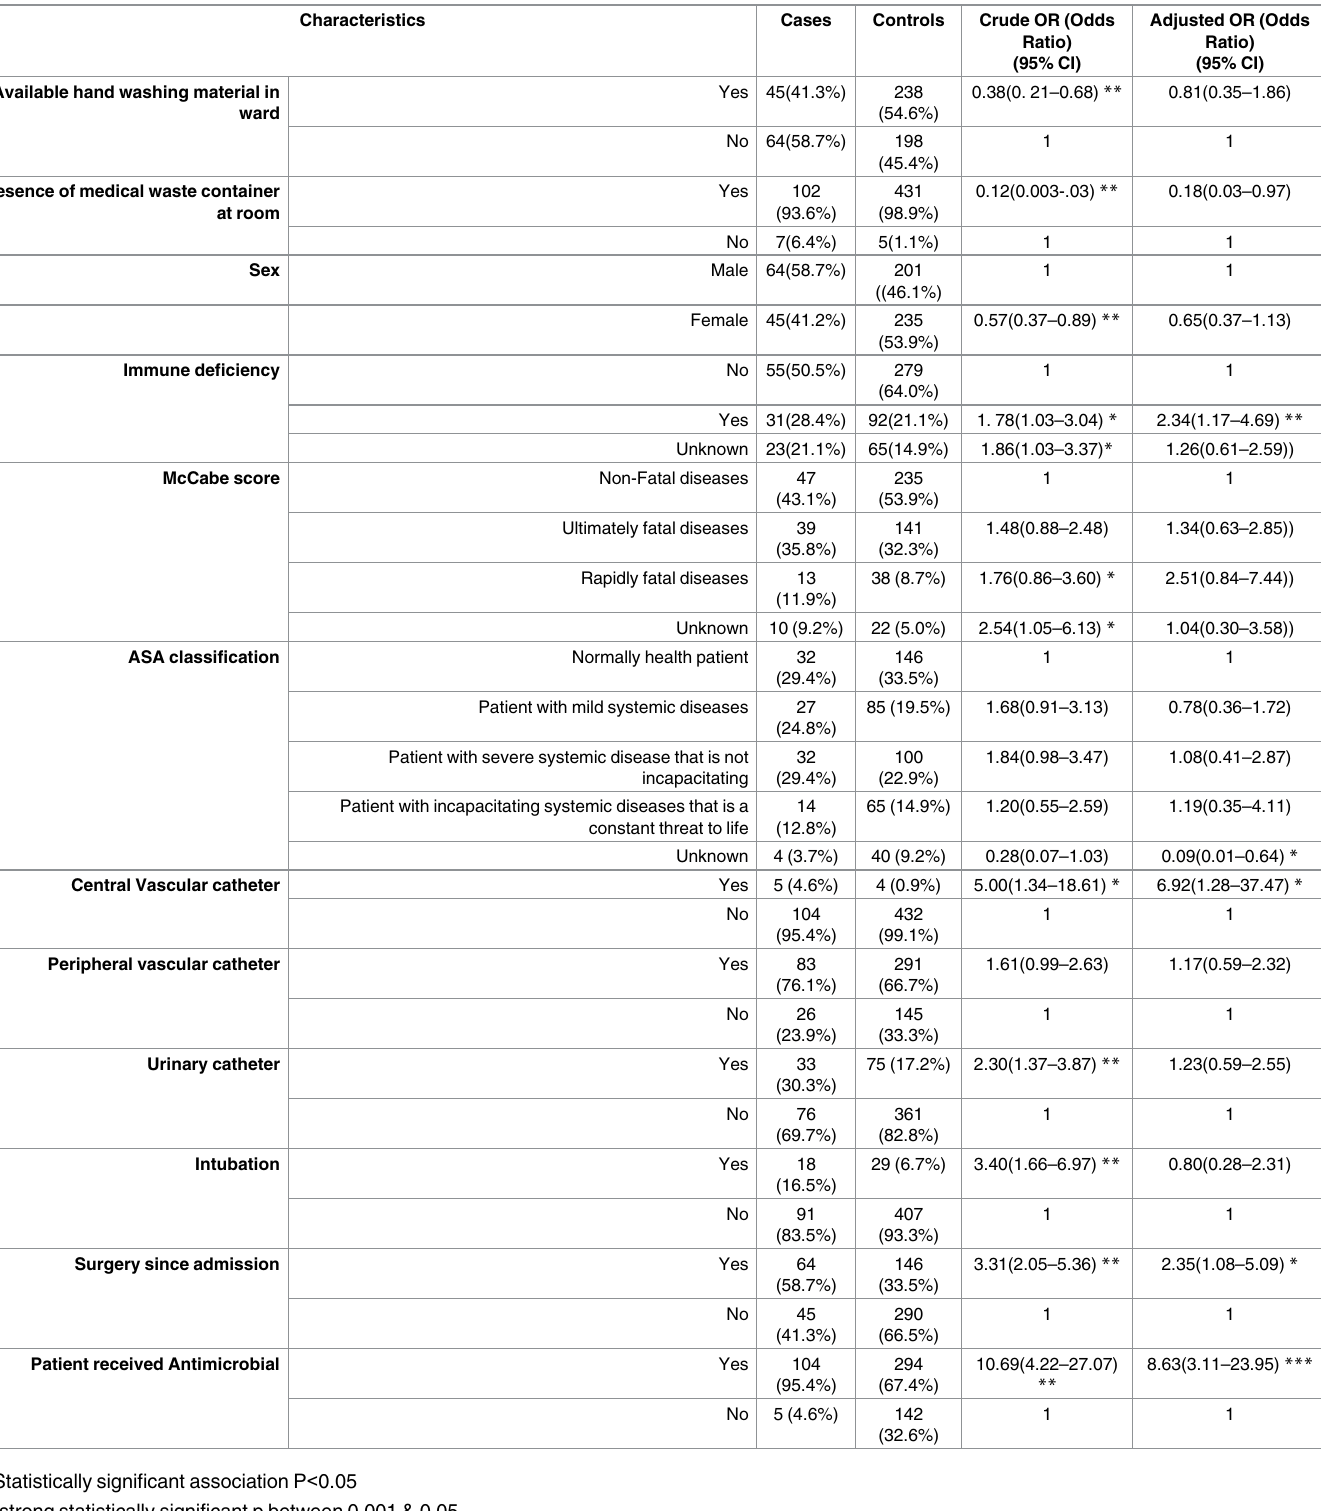
Table 2. Risk factors for HAI in teaching hospitals in Amhararegion, Ethiopia